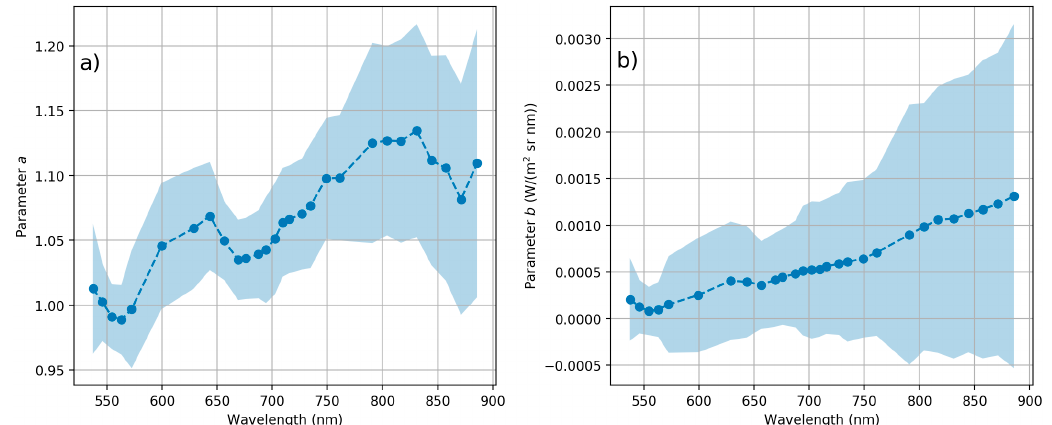
Figure 11. Band wise linear model parameters ( a ) a and ( b ) b to adjust L man radiance using Equation (6). Parameters solved using 11 data sets. Light blue colour indicates 95% confidence interval for parameters from least squares calculations.